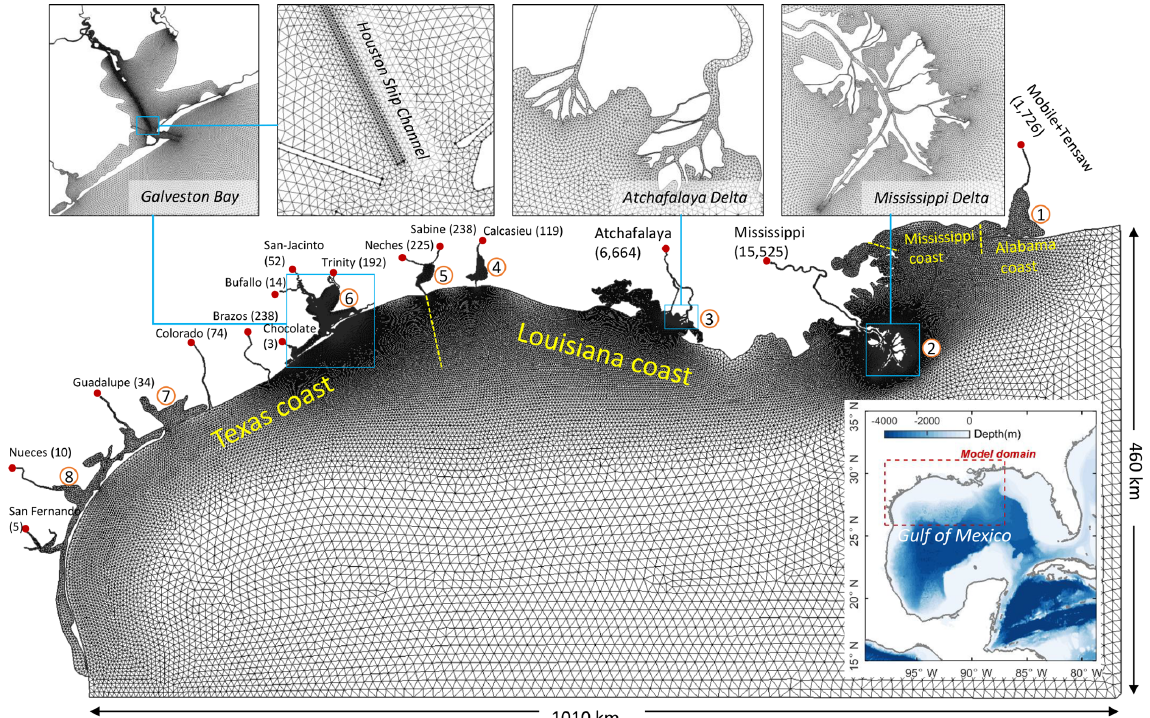
Figure 1. The model domain and the horizontal grid, with the upper panels showing zoomed-in views of selected coastal systems. Locations of major river inputs are indicated with red dots, with the associated mean river discharges (m 3 s − 1 ) shown in parentheses. Major estuarine bay systems in the model domain include Mobile Bay (1), Mississippi River (2), Atchafalaya River (3), Calcasieu Lake (4), Sabine Lake (5), Galveston Bay (6), Matagorda Bay (7), and Corpus Christi Bay